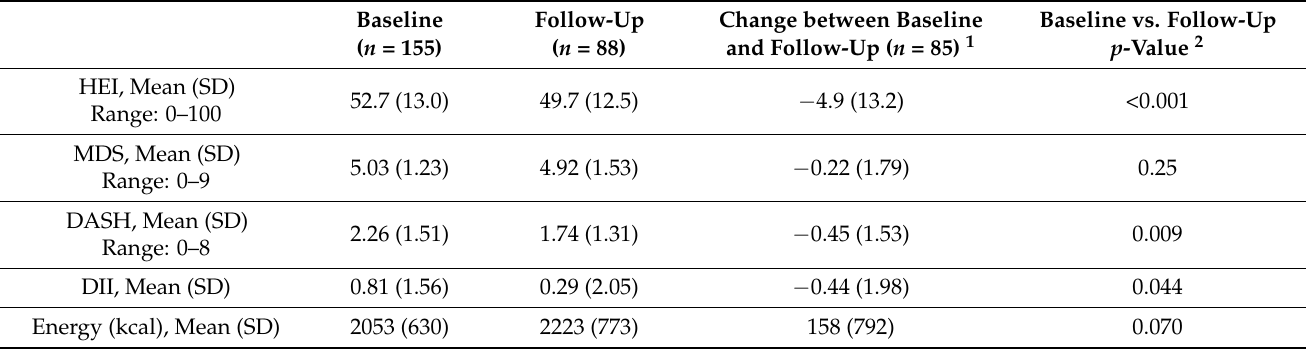
Table 2. Descriptive statistics for diet at baseline, follow-up, and change between visits.